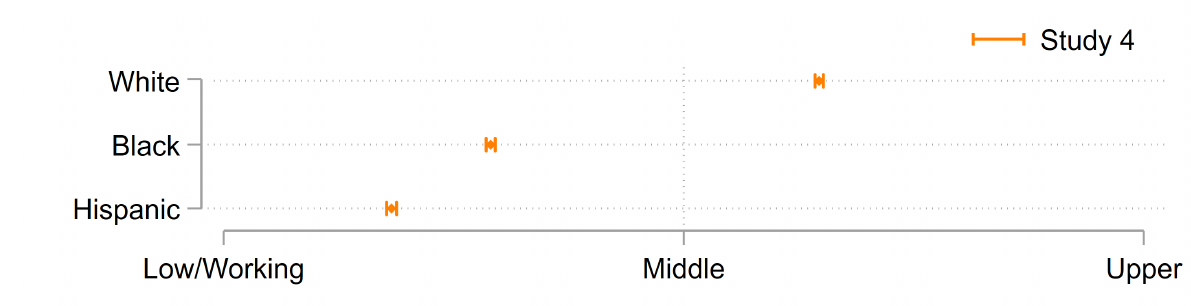
Figure 3: Social class perceptions by name-signaled race. Note: Data from Study 4. This plot shows respondent perceptions of social class based on names intended to signal different racial/ethnic categories. Plotted points denote predictions and bars represent 95 percent confidence